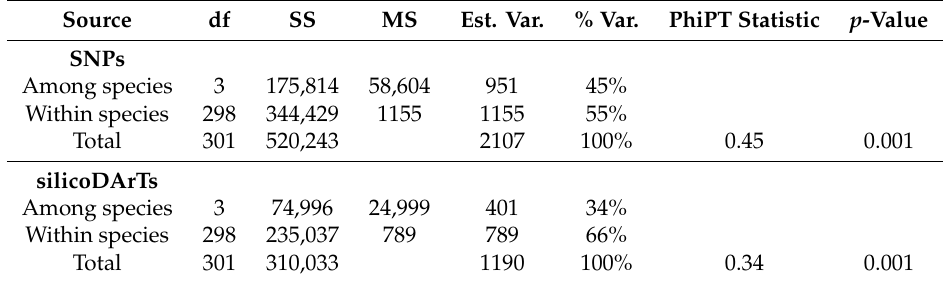
Table 3. Summary statistic of AMOVA analysis in Macadamia germplasm using SNP and silicoDArT markers. df = degrees of freedom, SS = sum of squared observations, MS = mean of squared observations, Est. Var = estimated variance, % Var. = percentage of total variance. PhiPT = var. among groups (species) / (var. among groups + var. within